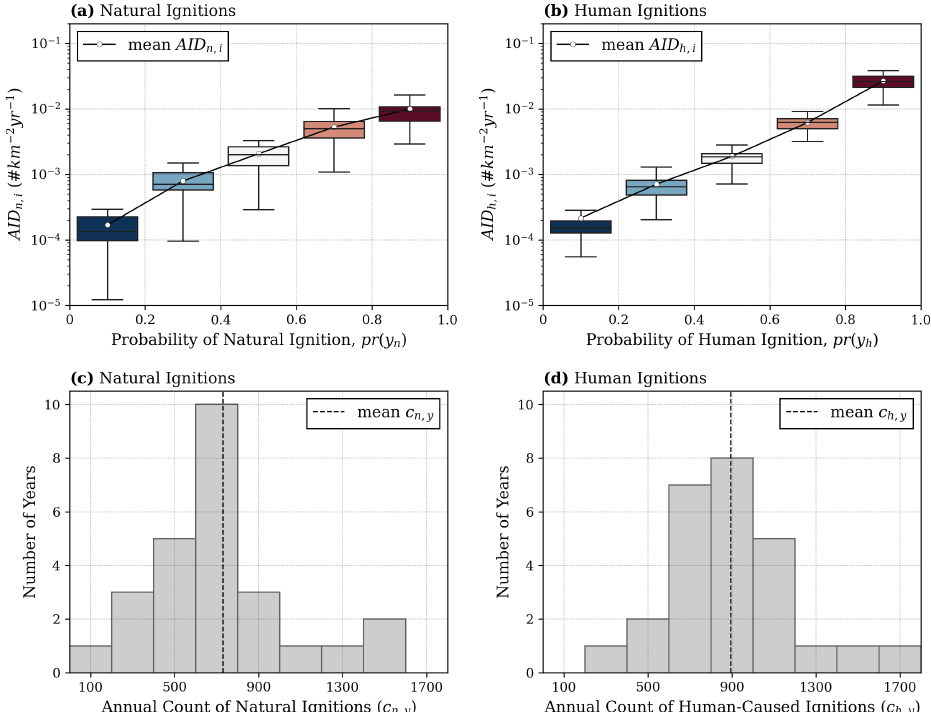
Figure 10. Shown in ( a , b ) are the distributions of annual ignition densities ( AID , # yr − 1 km − 1 ) for natural (subscript n ) and human-caused (subscript h ) wildfires calculated within each probability interval (subscript i ). Shown in ( c , d ) are the frequency distributions of the yearly (subscript y ) count of natural and human-caused ignitions along with their mean